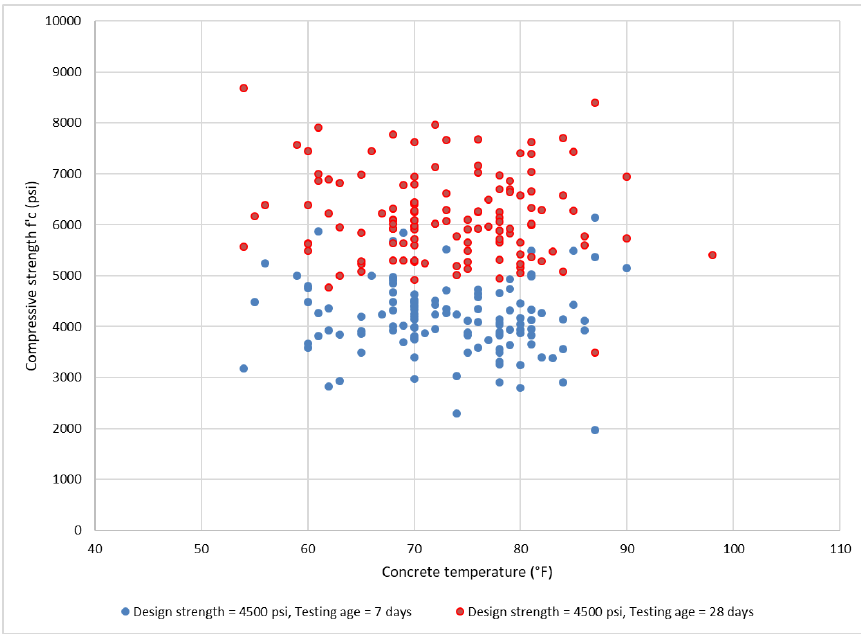
Figure 4. Relation between compressive strength and concrete temperature for a design strength of 4500 psi.